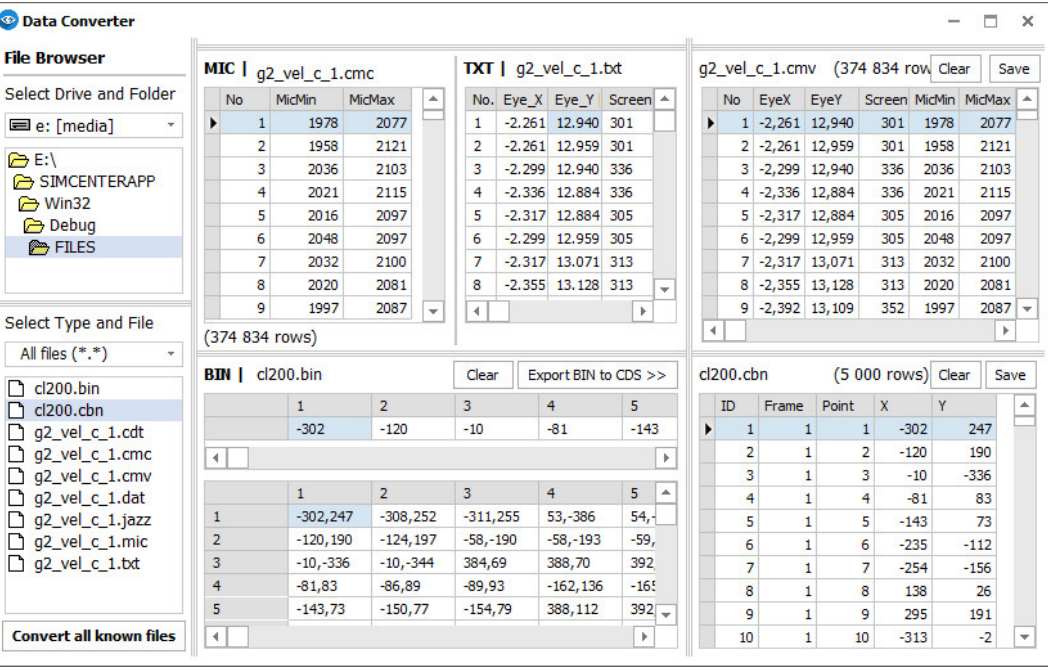
Figure 7. Working session with the data converter unit of the SimulationCenter application.